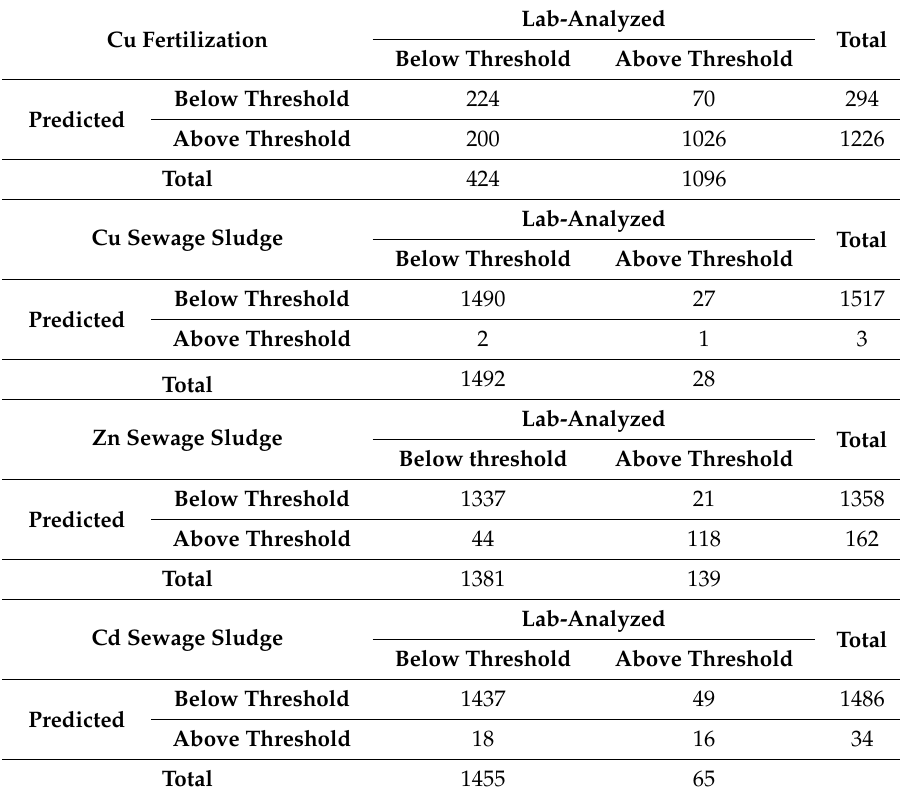
Table 6. Confusion matrices for classifications above and below thresholds for copper (Cu) fertilization and sewage sludge application for Cu, zinc (Zn), and cadmium (Cd) using the best models for each element in the cross-validation. Swedish recommendations suggest that there is risk of Cu deficiency if the Cu concentration in the soil is below 8 mg kg − 1 , while sewage sludge application is prohibited if the concentrations of Cu, Zn, and Cd exceed 40, 100, and 0.4 mg kg − 1 , respectively. Cu Fertilization